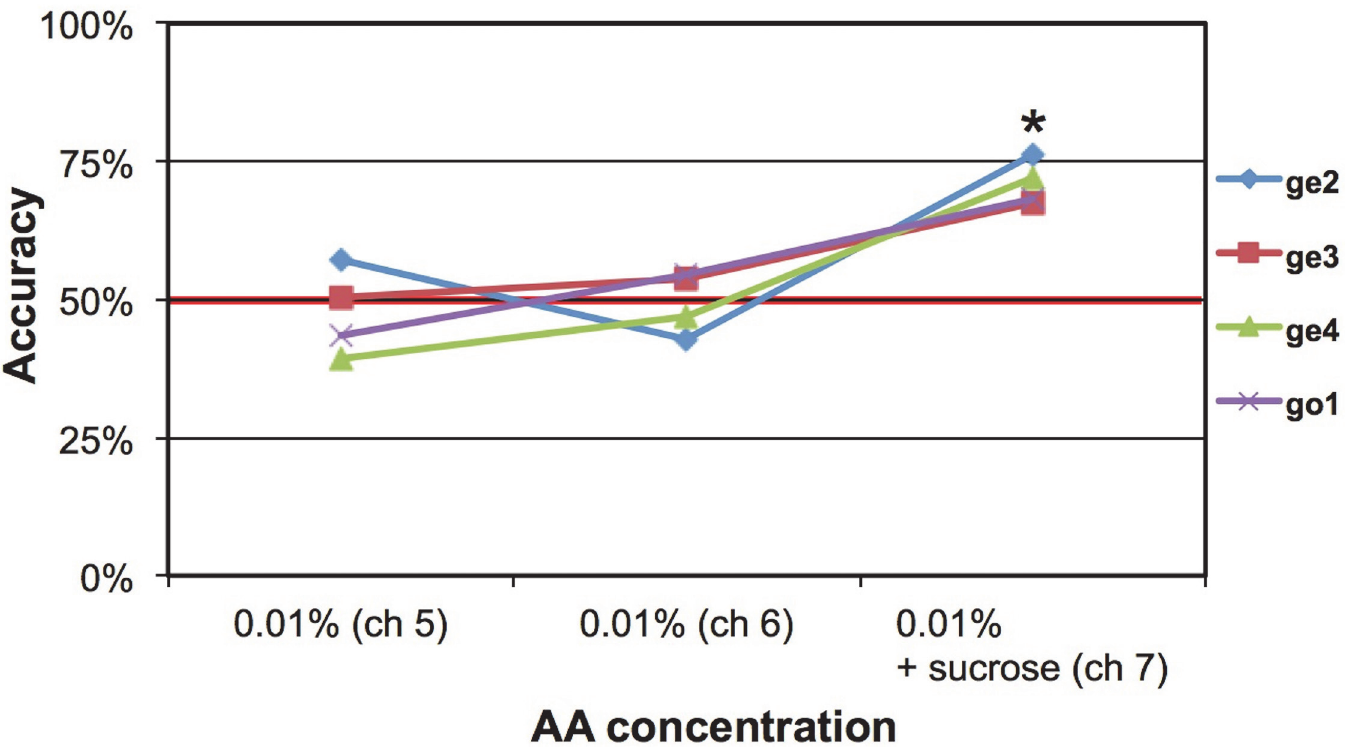
Fig 3. Accuracy after bulbectomy of 4 mice. Bulbectomized mice were unable to perform the discrimination task on two S+ gustometer channels presenting only the odor, but could detect the stimulus when admixed with 0.1M sucrose. * p < 0.0001 (unpaired t-test for performance > 50%). Mouse labels: ge: GCaMP3-EMX; go: GCaMP2-OMP.